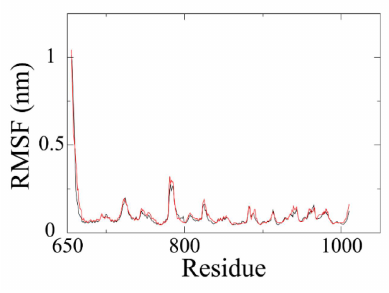
Figure 5. RMSF plots of backbone atoms for PARP1 ® Cinhibitor systems. Black line is for olaparib and red line is the PARP1-ZINC67913374